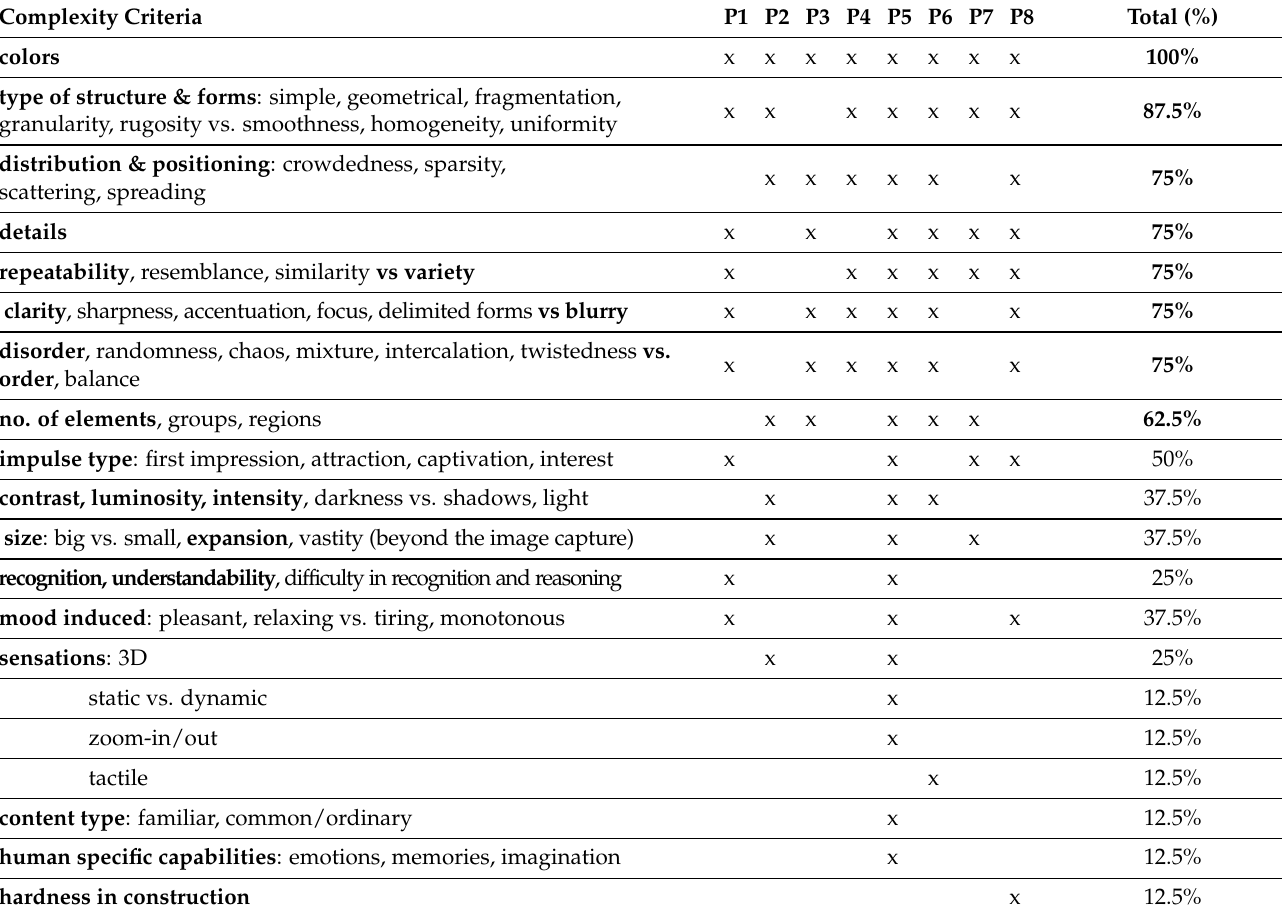
Table 1. Complexity